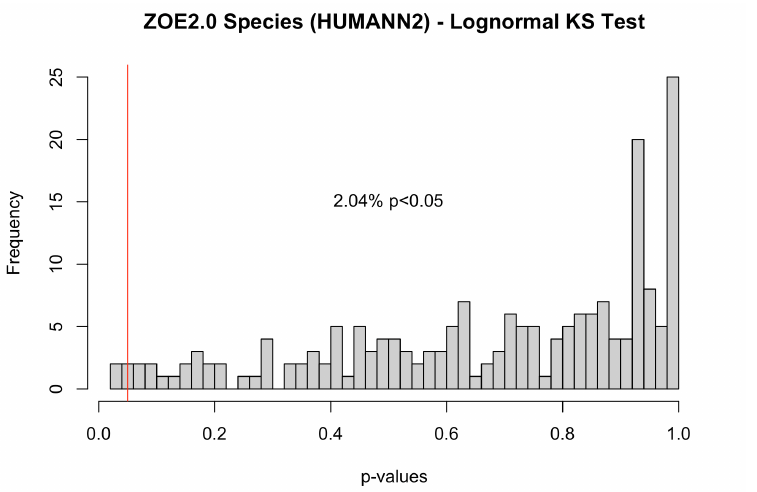
Figure A3. p -values obtained from lognormal (parameters from models fitted on nonzero counts for each metabolite and species) Kolmogorov–Smirnov test for ZOE 2.0 metabolites and HUMAnN 2.0 microbiome species. The red vertical line represents a p -value of 0.05 so that p -values below it indicate statistical significance in the